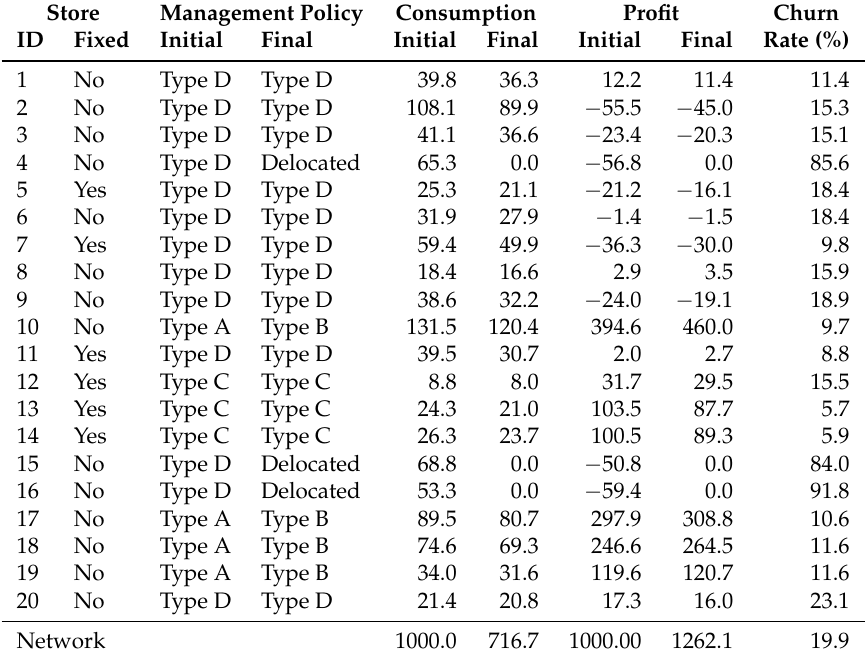
Table 3. Characteristics of the stores before and after